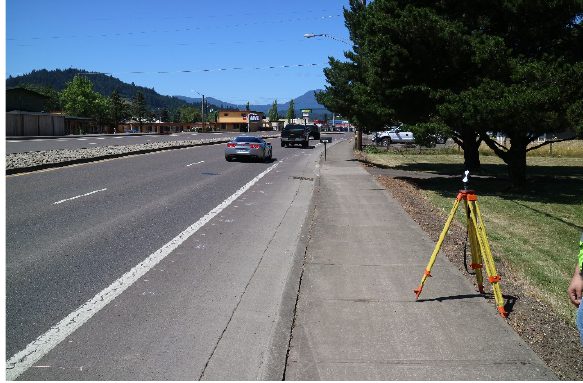
Figure 1. Photograph of the Philomath site with stripe of variable wear showing chalk markings at 0.5 m increments First, we marked the stripe every 0.5 m along the center of the longitudinal stripe, to consistently locate a total of 155 measurement point was captured with a Leica TS15 total